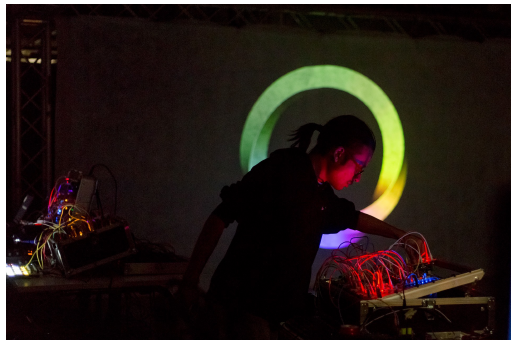
Figure 2. The first author performing with the prototype synthesizer at Ääniaalto